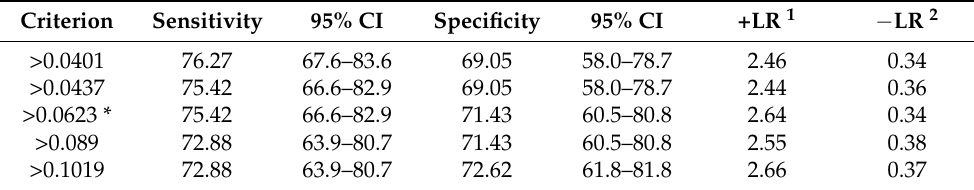
Figure 5. Receiver operating characteristic (ROC) curve showing the performance of the EHDV analyte in the BTV/EHDV duplex FMIA at all classification thresholds. The area under the curve (AUC) of 0.764 ( p < 0.001) gave an acceptable relationship [51] between the ability of the FMIA to detect EHDV antibody-positive samples when compared to the EHDV cELISA. Table 2. Sample value/positive value (S/P) criterion of positivity (>0.0623 *) for the EHDV analyte in the BTV/EHDV duplex FMIA. MedCalc was used to determine sensitivity and specificity at a 95% confidence interval